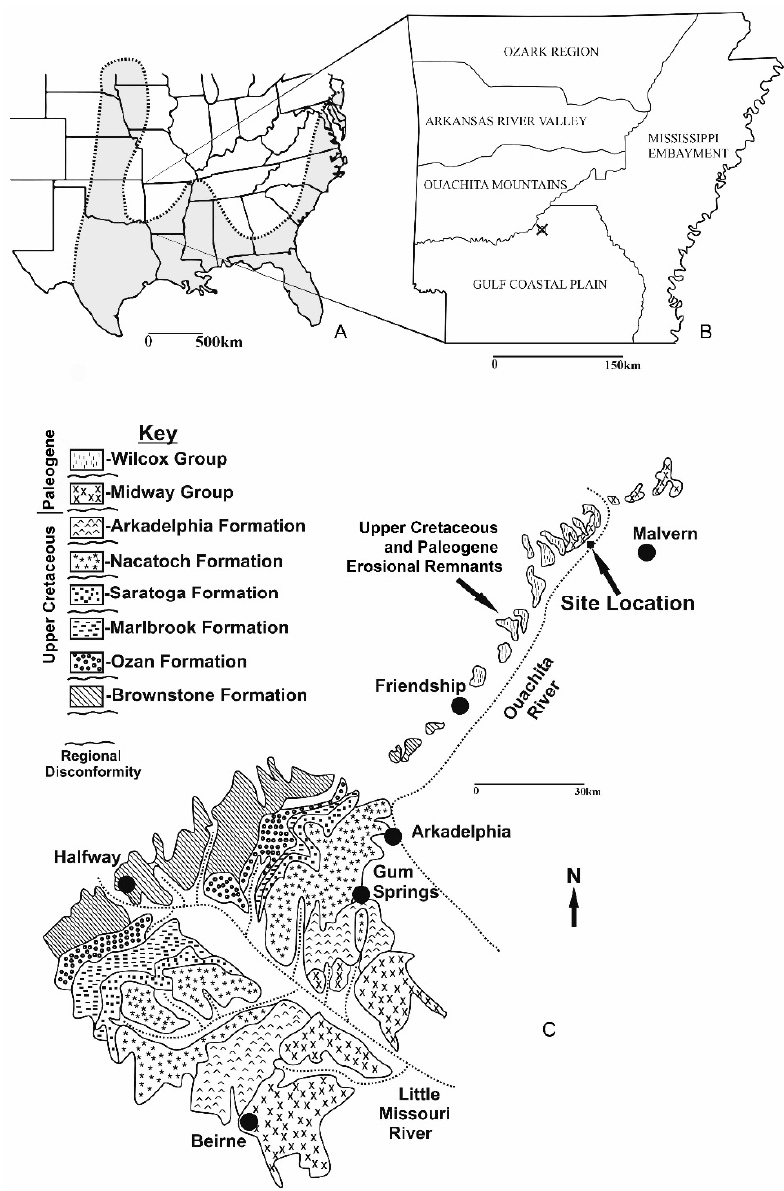
Figure 1. Location maps for the Arkadelphia Formation—Midway Group (late Maastrichtian— Paleocene) turtles from Hot Spring County, Arkansas (modified from Becker et al. [3]). ( A ) Late Maastrichtian ( Jeletzkytes nebrascensis Zone) paleogeographic reconstruction of the Atlantic and Gulf Coastal plains and Western Interior Seaway; ( B ) physiographic provinces in Arkansas with turtle site discussed in this study indicated by (X); ( C ) geologic map and stratigraphic column of Upper Cretaceous and Paleogene formations in the study area of southwestern Arkansas and Arkadelphia Formation—Midway Group turtle site discussed in this study identified by arrows.